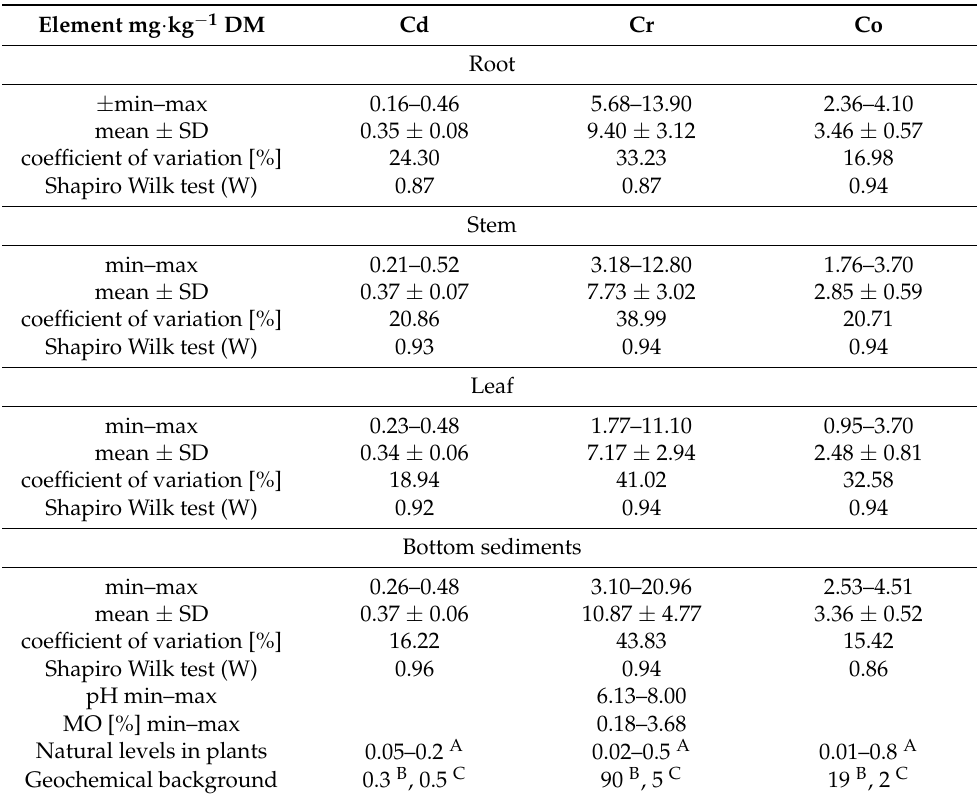
Table 2. Basic statistical data ( n —11) of the content of studied indicators in bottom sediments and Glyceria maxima (root, stem, and leaf) in Pisa River and its